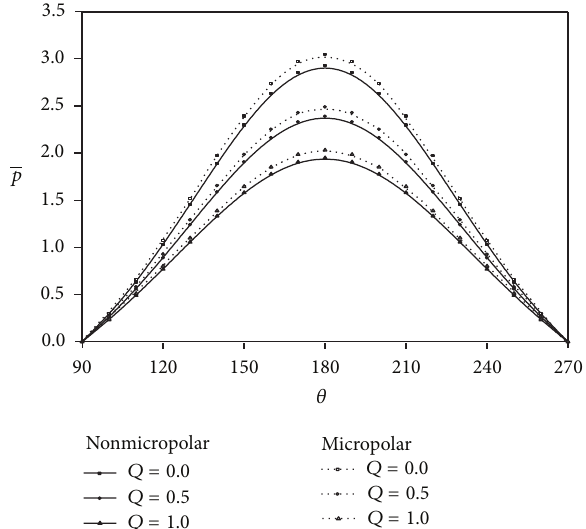
Figure 2: Variation of nondimensional pressure with 𝜃 for different values of 𝑄 with 𝑙 = (0.0,0.4) , 𝑁 = 0.2 , 𝜆 = 0.5 , and 𝜀 = 0.2